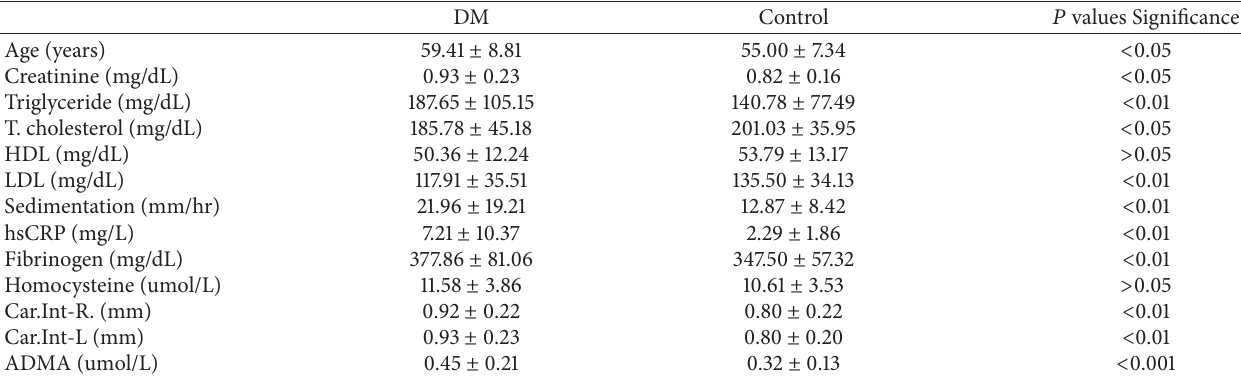
Table 2: Comparison of the common parameters in all diabetic patients and the control